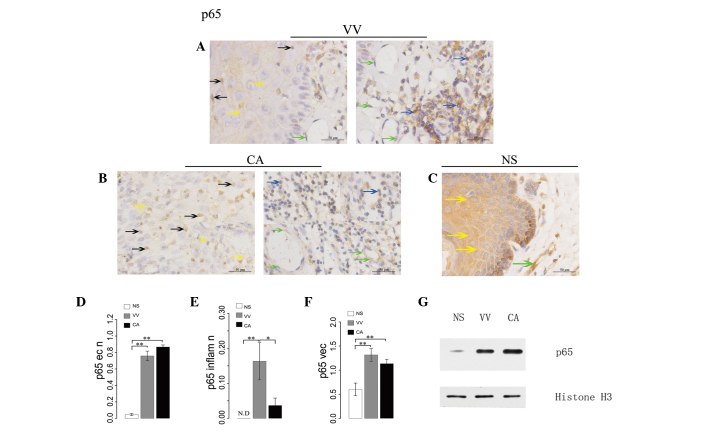
p65 expression in NS and wart samples by immunohistochemistry EnVision (magnification, ×400). (A-C) p65 positive expression is located in the cells, cytoplasm and/or nuclei following activation. The black arrows represent p65 expression in the epithelial nuclei, the yellow arrows represent p65 expression in the epithelial cytoplasm, the blue arrows represent p65 expression in inflammatory cells and the green arrows represent p65 expression in vascular endothelial cells. (D) p65 expression in the epithelial nuclei. (E) p65 expression in inflammatory cell nuclei. (F) p65 expression in the vascular endothelial cells. The error bars represent the standard error of the mean. *P<0.05 and **P<0.01. (G) Western blot detection of p65 expression in the epithelial nuclei, which increased from NS to VV to CA. Histone H3 was adopted as a loading control. CA, condyloma acuminatum; VV, verruca vulgaris; NS, normal skin.